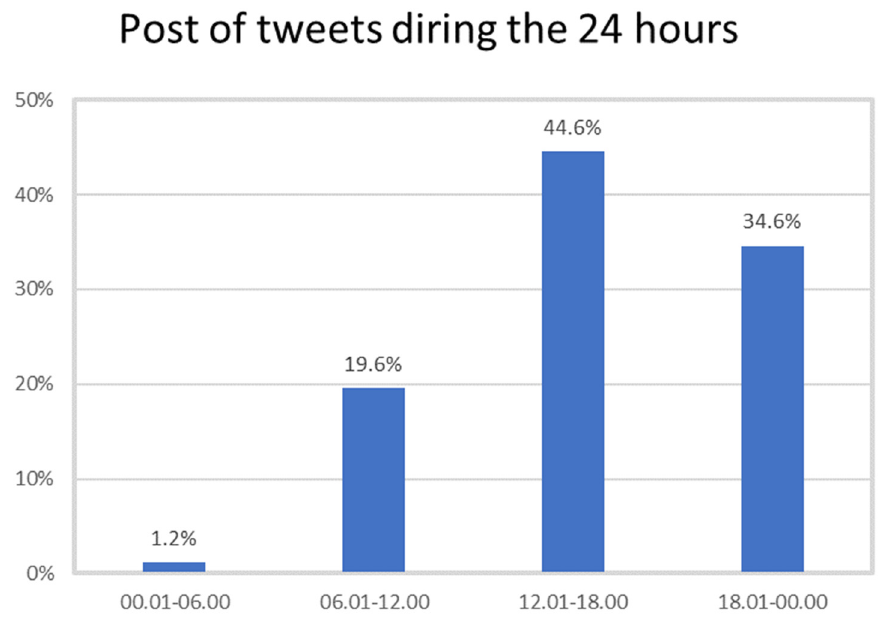
Figure 1. Posts of tweets during 24 h (%).